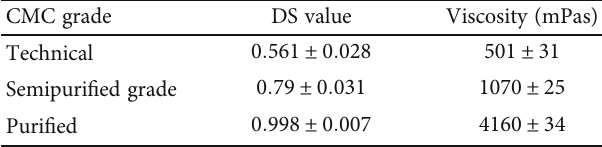
Table 5: Degree of substitution (DS), viscosity of prepared CMC. CMC grade DS value